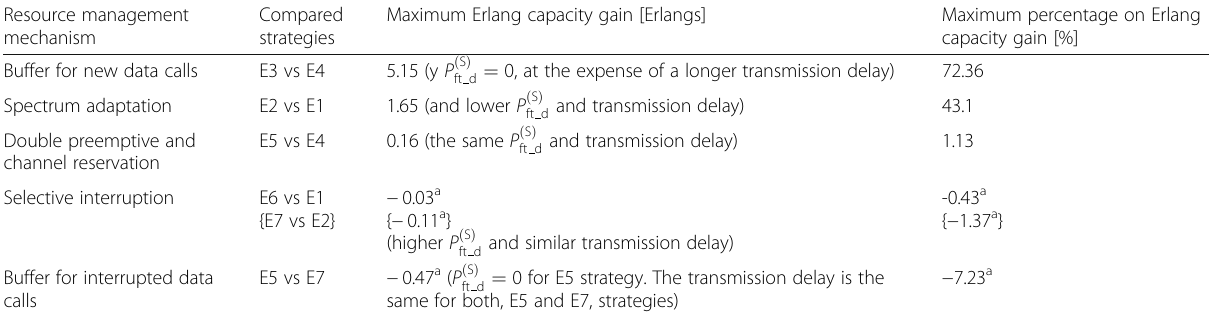
Table 4 Maximum percentage on Erlang capacity gain given for every single considered resource management mechanism when M = 6, N = 3, f b v = 0.4767, max = 3 and, a maximum value of